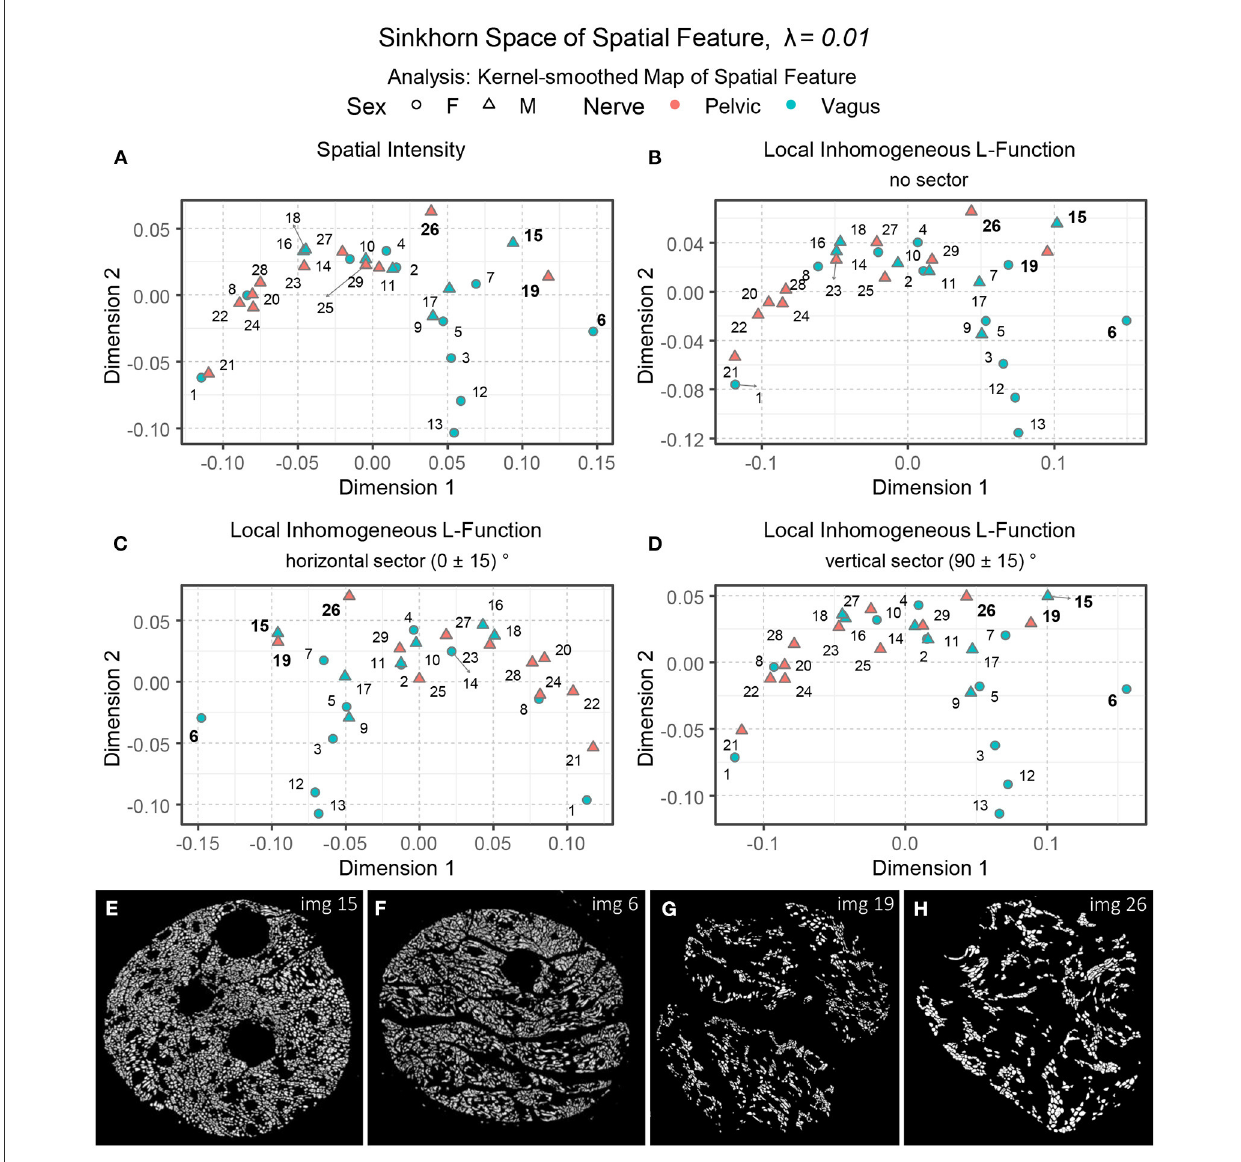
FIGURE12 (A–D) The embeddings of the kernel-smoothed spatial intensity and the local inhomogeneous and anisotropic L -functions (no sector, horizontal sector, and vertical sector) of the spatial point patterns in the Sinkhorn space for entropic regularization parameter λ = 0.01. The vagus and the pelvic samples are shown in cyan and orange [circles for female (F) and triangles for male (M)], respectively, and labeled with the Image ID listed in Table 1. (E–H) The segmented unmyelinated axons of Image 15 and 6 (vagus) and Image 19 and 26 (pelvic) listed in Table